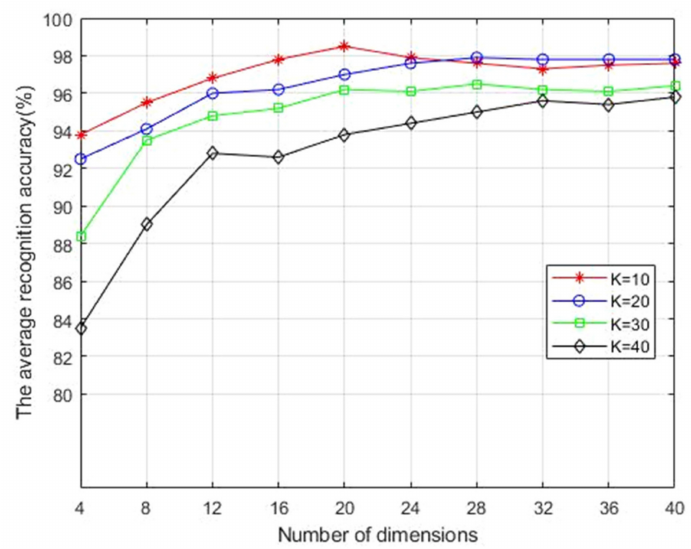
Figure 2. Average recognition accuracy (%) of the 2DESDLPP algorithm corresponding to different K values with feature dimensions when the training sample in the ORL database is 6.